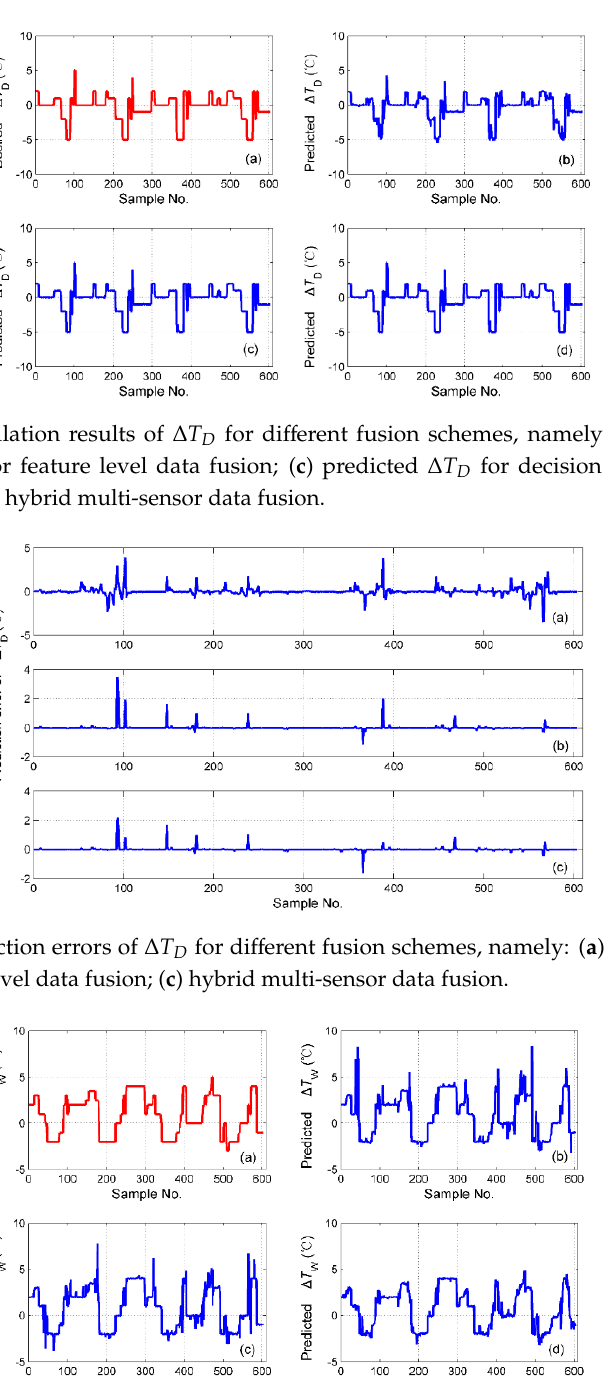
Figure 17. The prediction errors of 𝑡 𝑠 for the different fusion schemes, namely: ( a ) feature level data fusion; ( b ) decision level data fusion; ( c ) hybrid multi-sensor data fusion.